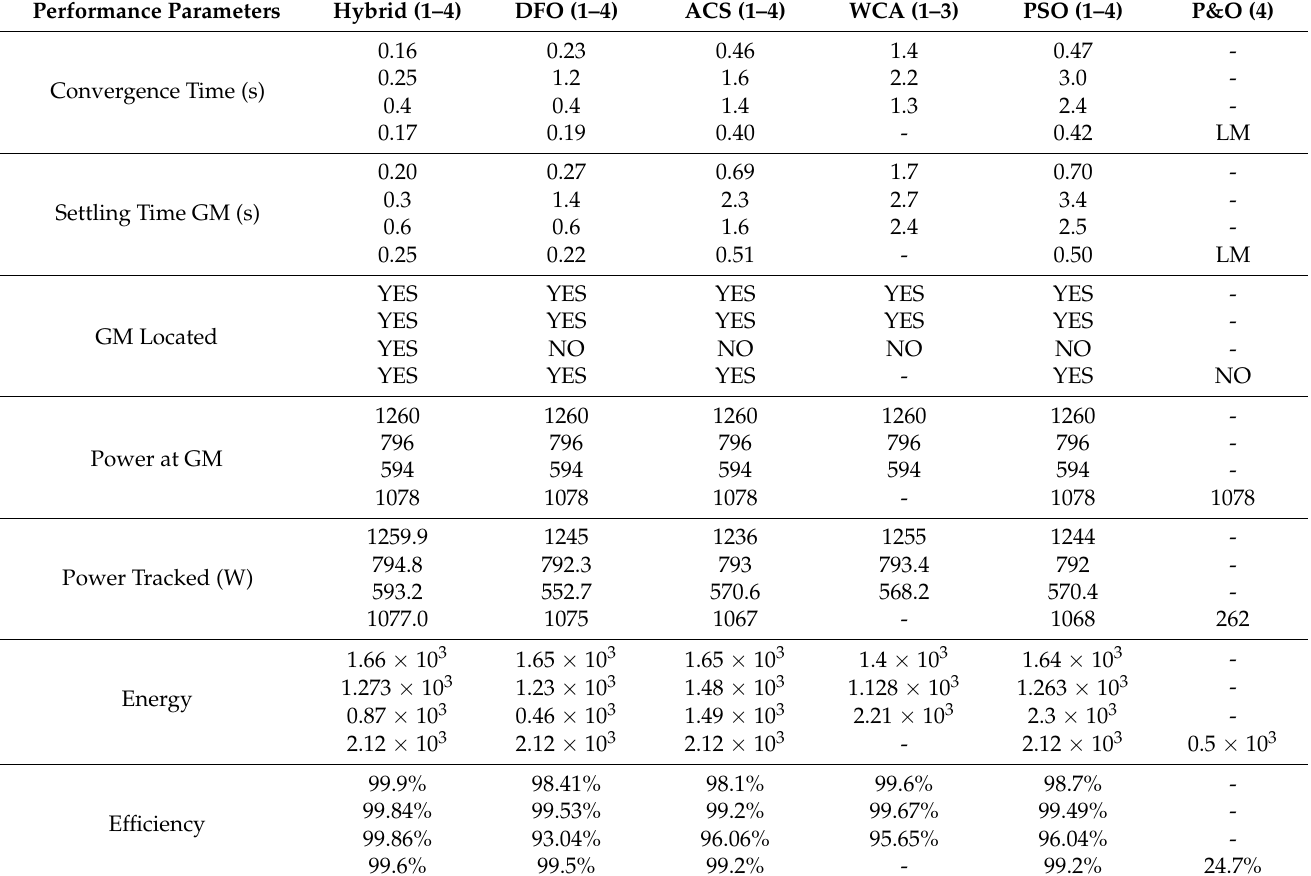
Table 3. Technical comparison of hybrid technique with other implemented